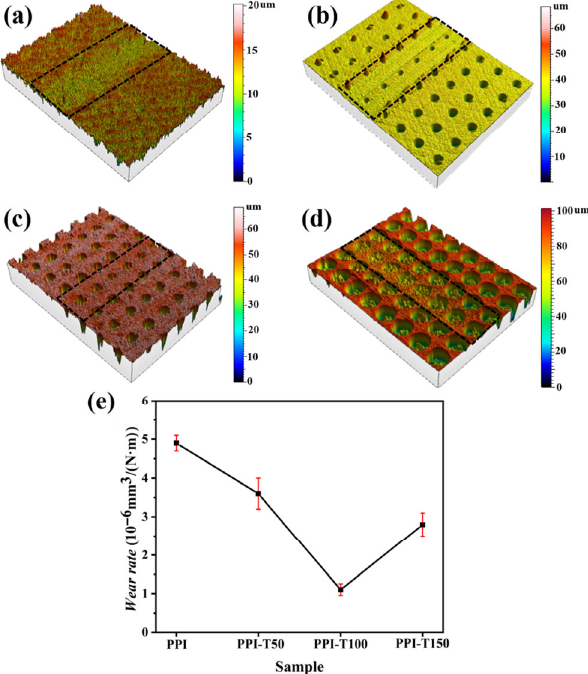
Fig. 8 Surface morphology of (a) OCPPI, (b) OCHPPI-T50, (c) OCHPPI-T100, and (d) OCHPPI-T150 after the friction experiment and (e) wear rate of rubbed